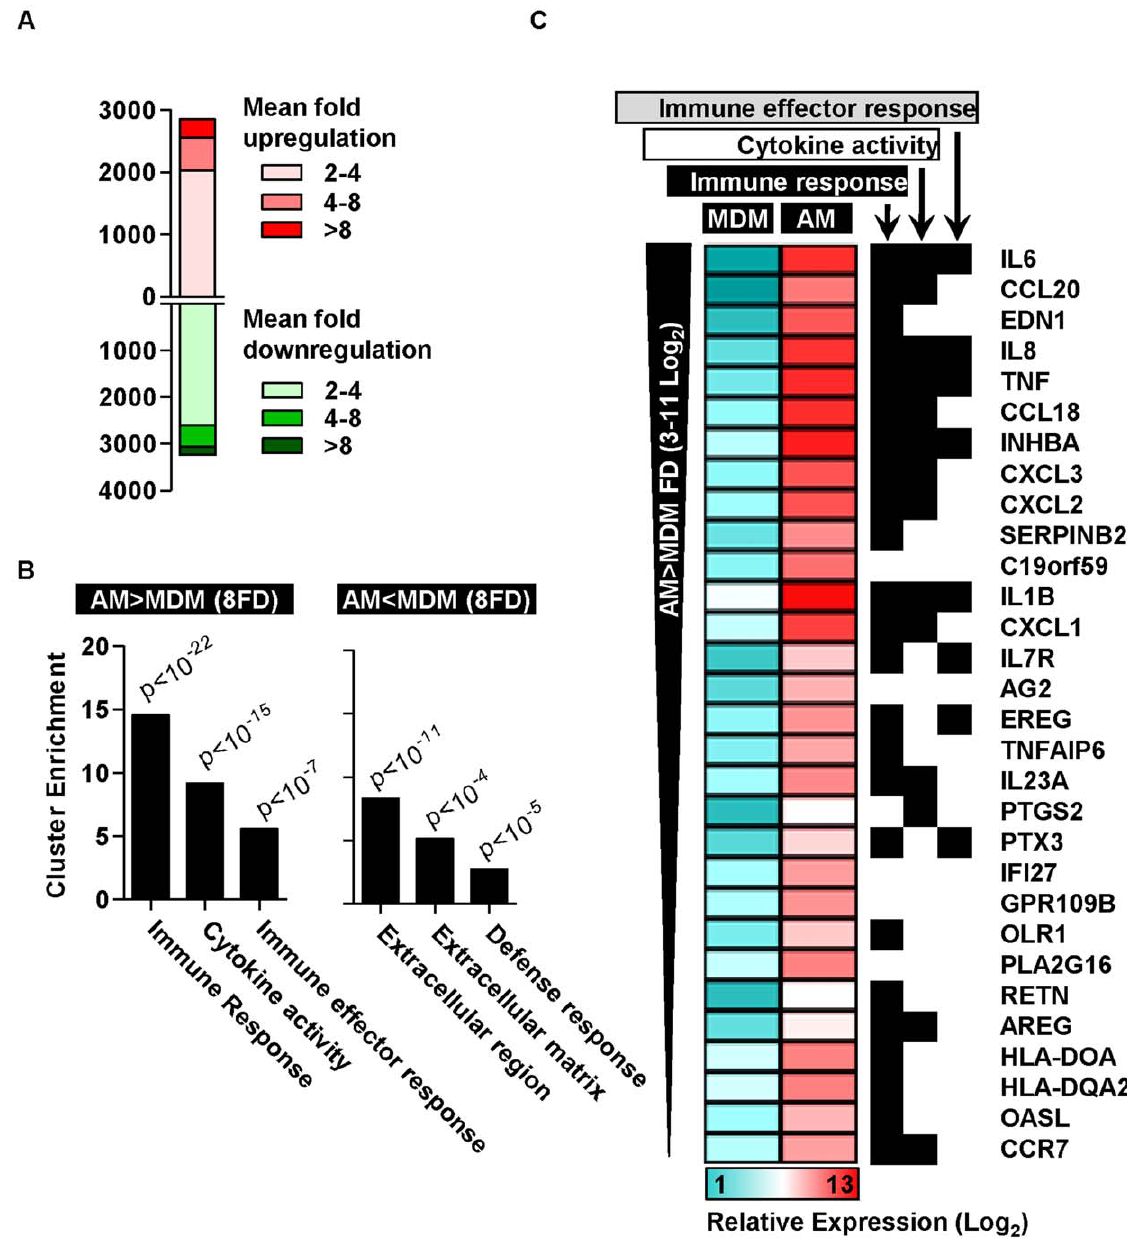
Figure 2. Differences in transcriptional profiles of AM and MDM. (A) Comparison of transcriptional profiles of AM and MDM shows extensive gene expression differences. (B) Functional annotation clustering of significant gene expression differences ( . 8-fold and p , 0.05, t-test) shows that genes upregulated in AM are highly enriched for immune responses and cytokine activity, whereas downregulated genes show less significant enrichment for defense responses and extracellular processes (Modified Fisher’s Exact Test). (C) The three most significantly enriched gene ontology associations are shown for the top 30 most highly upregulated genes in AM.